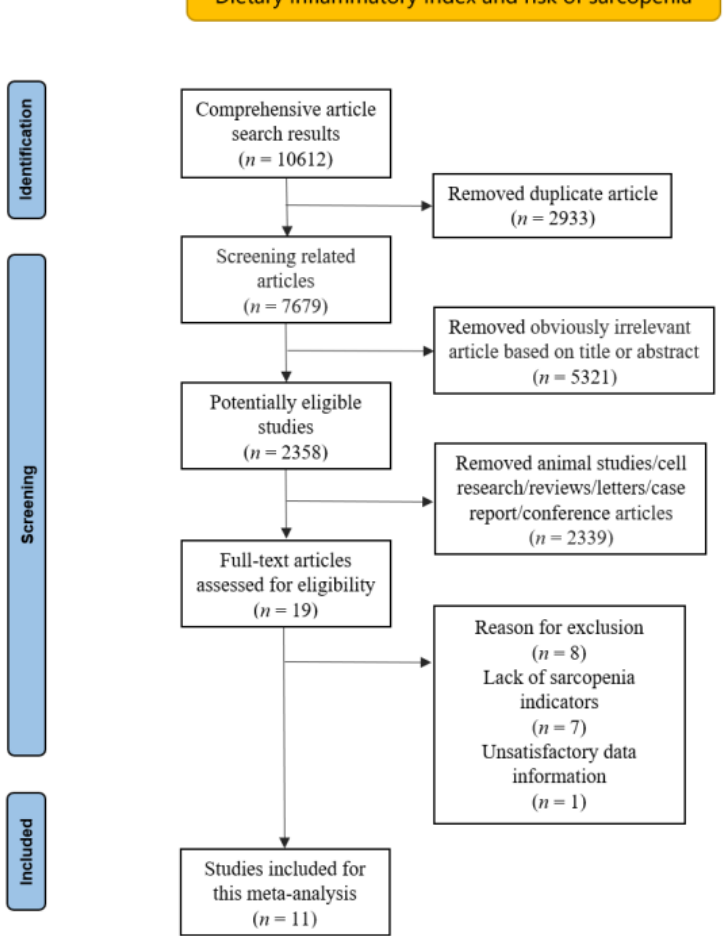
Figure 1. Flow diagram of the literature search and selection.